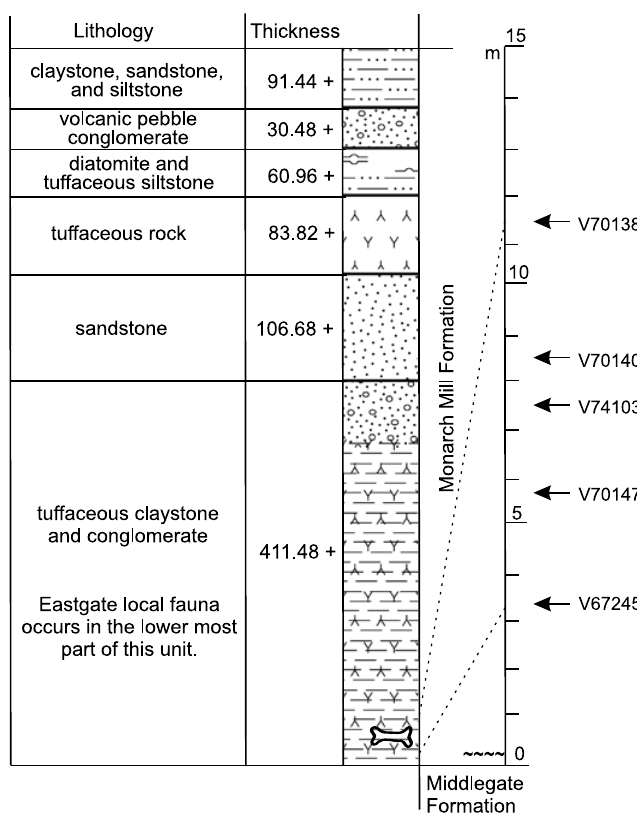
Fig. 2. Basic stratigraphic column of the Monarch Mill Formation show- ing the dominant lithologies (modified from Axelrod 1956). Stratigraphic positions of the Eastgate LF localities is indicated with the “bone” sym- bol. Adjacent plot of the stratigraphic positions of select localities plotted above the base of the Monarch Mill Formation relative to the “clay change” that seems to delineate the boundary between the Middlegate and Monarch Mill formations (indicated by wavy lines at the base of the column; Darrin Pagnac, personal communication 2014). Basalts for preliminary radiometric dates reported were collected between UCMP V70147 and UCMP